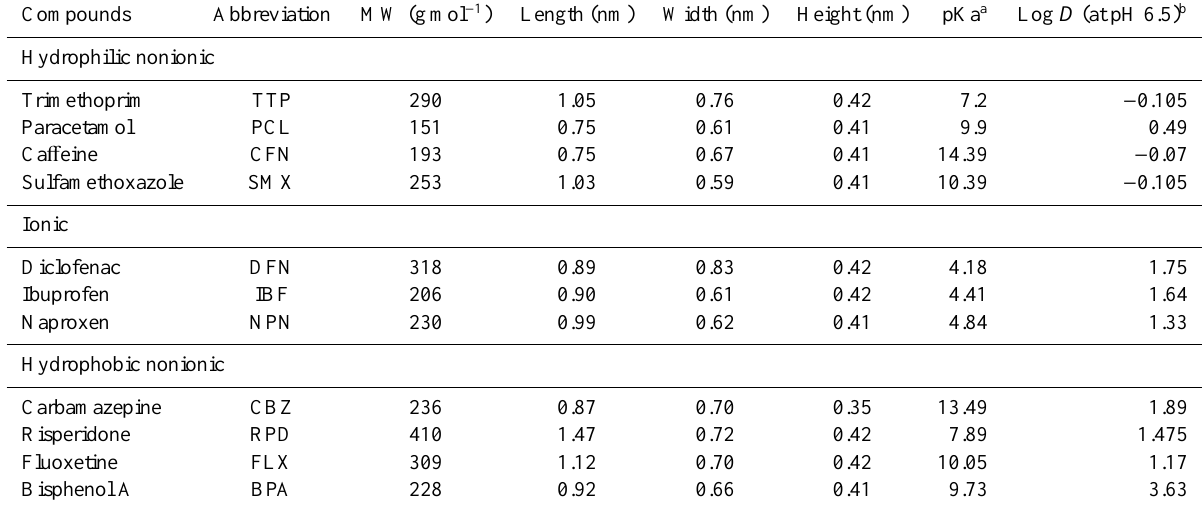
Table 2. Properties of selected trace organic compounds.